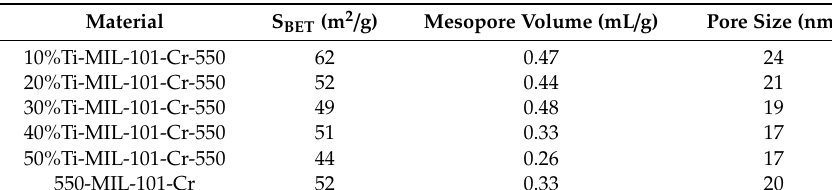
Table 2. Textual properties of various samples.